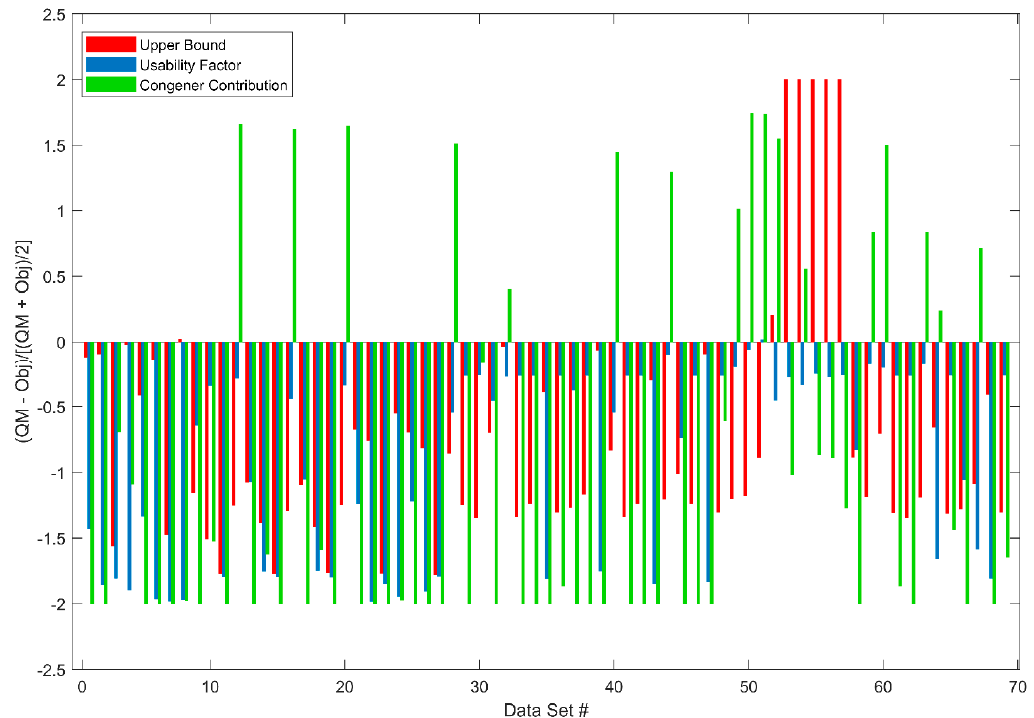
Figure 6. Difference between quality metrics and their objectives for upper bound (red bars), usability factor (blue bars), and congener contribution (green bars) are shown on the y axis for the 69 Target Data sets. The x axis gives the order of the 69 Target Data sets. For the same dataset, if all three bars are above zero, the dataset is not usable; otherwise, it is assessed as usable. #: Data Set.